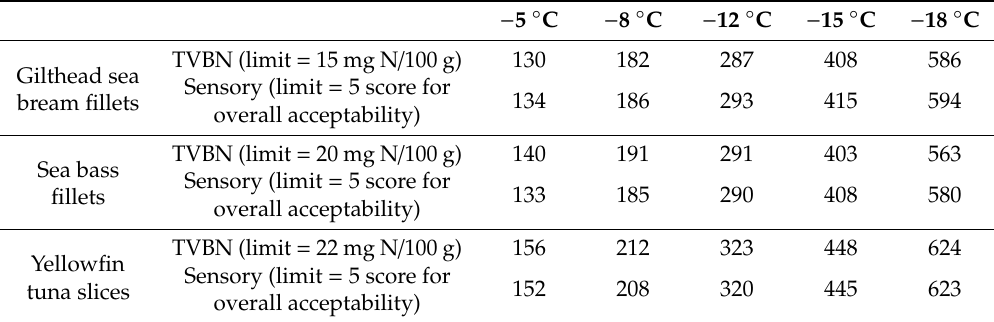
Table 4. Shelf life (days) of frozen gilthead sea bream fillets, sea bass fillets and yellowfin tuna slices stored at di ff erent